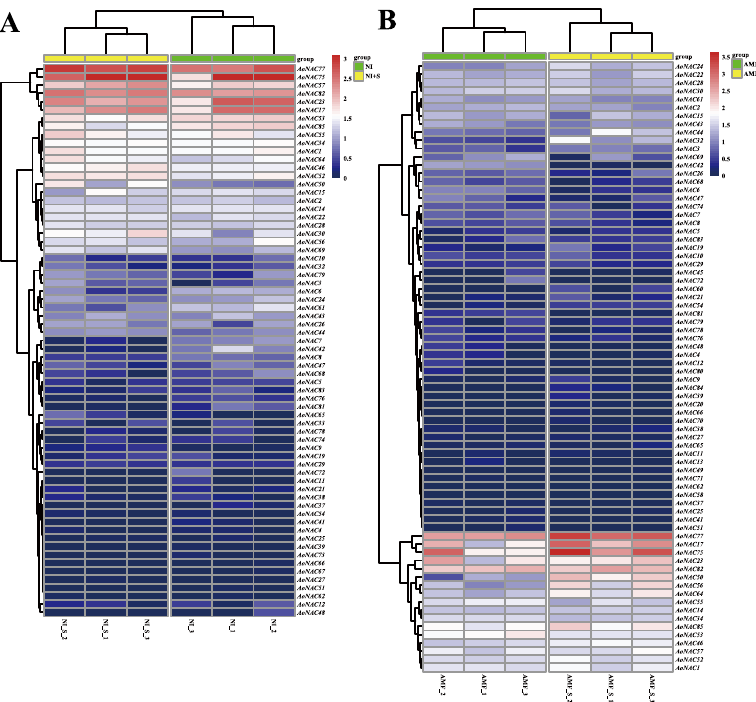
Figure 8. Differential gene expression of AoNAC genes under different types of salinity stress: ( A ) non-inoculated A. officinalis plants without salinity stress (NI) and non-inoculated A. officinalis plants subjected to salinity stress (NI + S); ( B ) inoculated A. officinalis plants without salinity stress (AMF) and inoculated A. officinalis plants subjected to salinity stress (AMF + S). Heatmaps are based on the log10-transformed RPKM values. Red represents a high expression level, and blue represents a low expression level. Volcano plots are based on the significantly adjusted p -value (padj) < 0.05 and an absolute value of log2FC (log of fold change) > 1.